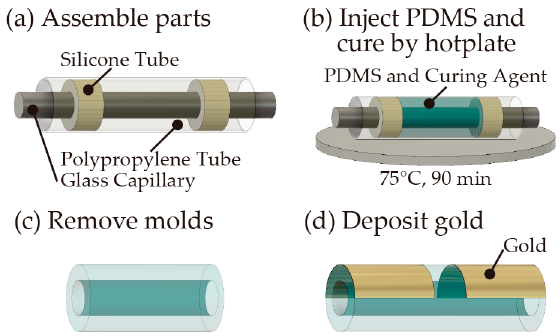
Figure 3. The polydimethylsiloxane (PDMS) tube molding and wiring processes.